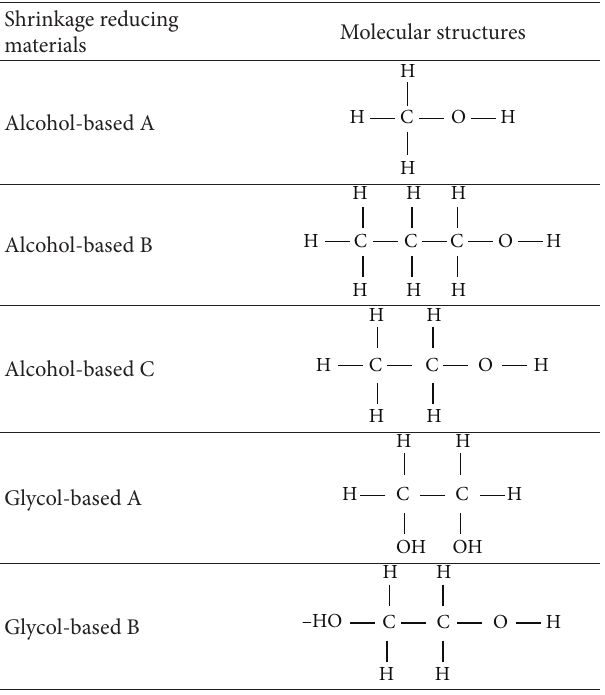
Table 3: Molecular structures of shrinkage reducing materials in use.